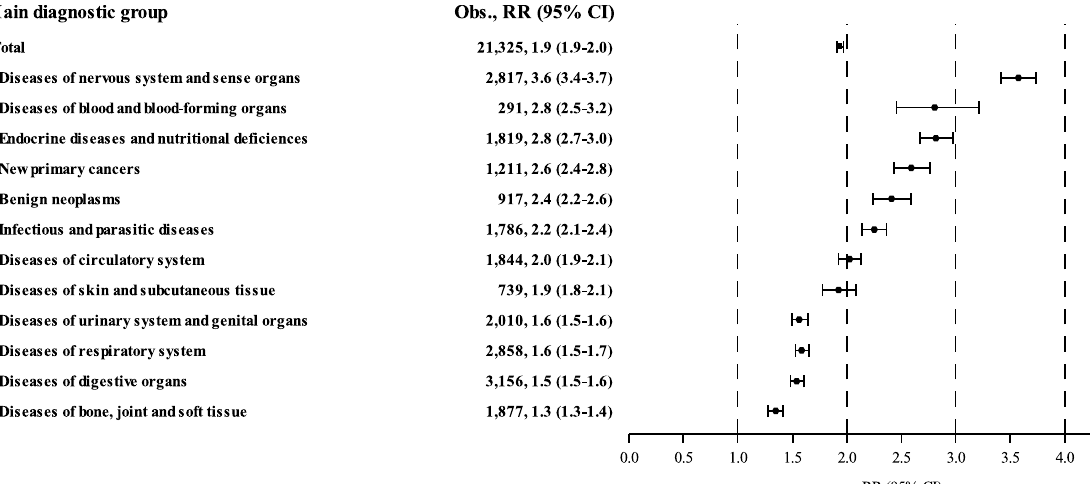
Table. Particularly high relative risks were seen for pituitary hypofunction (RR: 72.0; n = 341), testicular dysfunction (RR: 22..9; n = 19), tumours of the central nervous system (CNS) (RR: 11.8; n = 257), and herpes zoster (RR: 11.2; n = 58).